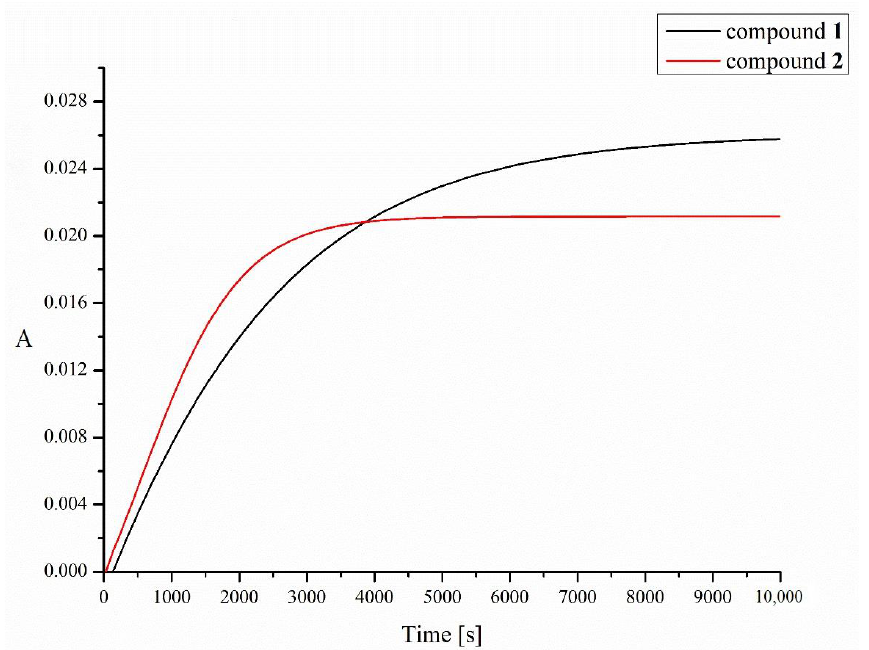
Figure 3. Time dependence of UV absorbance (at 260 nm) of compounds 1 (black line) and 2 (red line) in the presence of 2 mM of L-glutathione (GSH). A is absorbance.